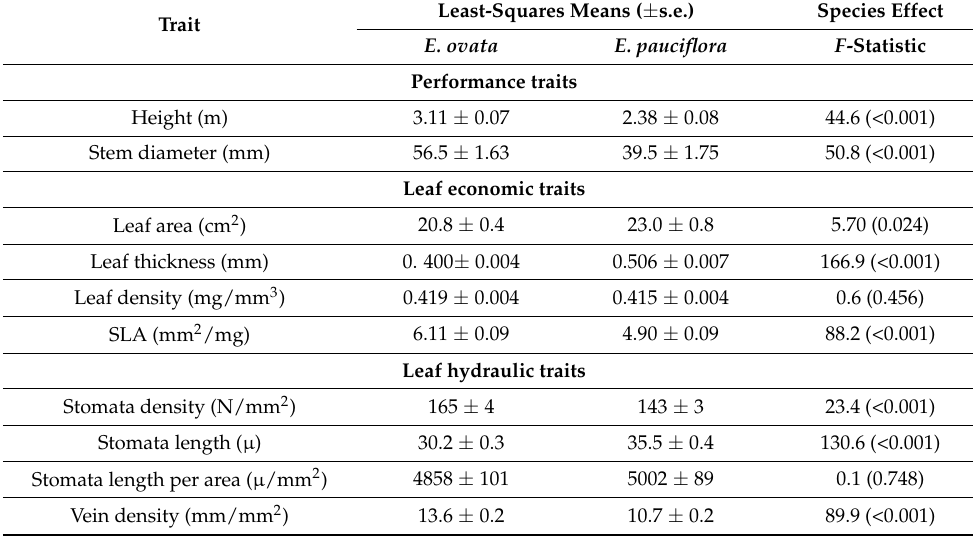
Table 1. Estimated least-squares means ( ± s.e.) and results obtained from statistical testing ( F -statistic, and associated p -value in parentheses) of the null hypothesis of no species effect, for the variables (performance and leaf traits) measured from 22 co-occurring populations of 2-year-old E. ovata and E. pauciflora trees growing in a common